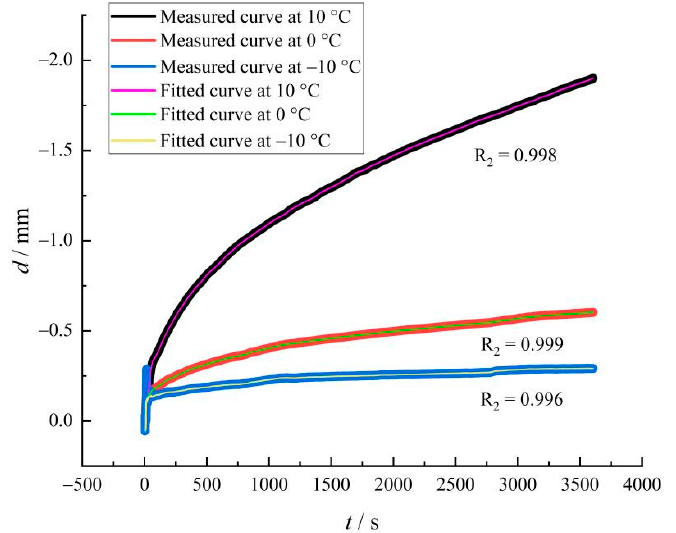
Figure 11. Measured displacement and fitted curve of wood tar-based rejuvenated asphalt mixture.